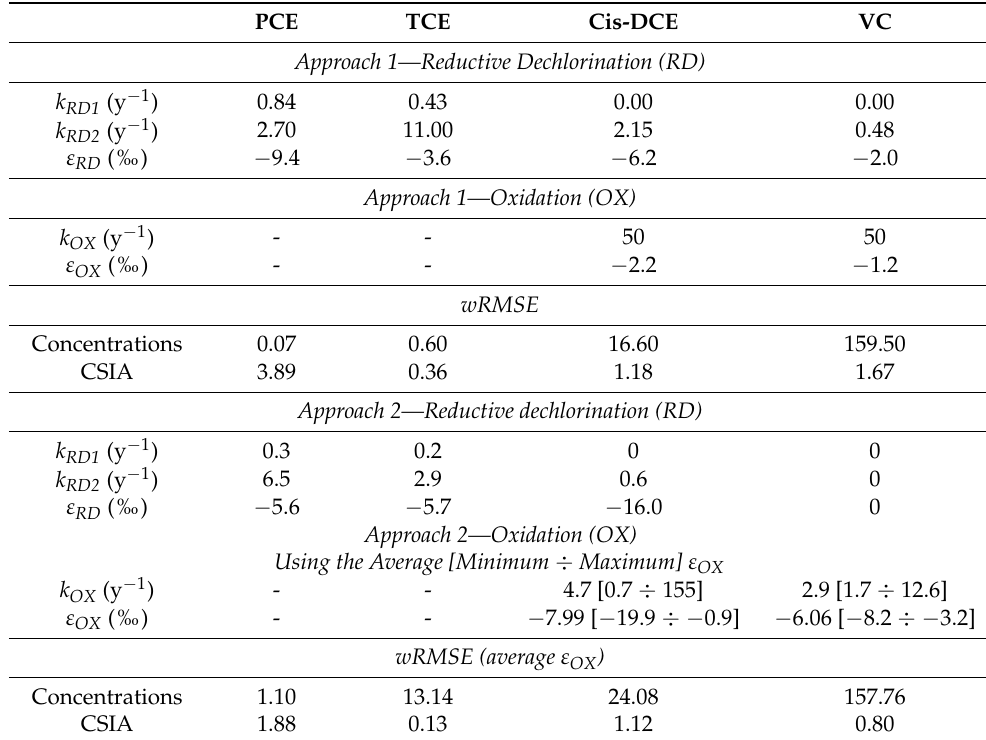
Table 6. Calibrated k and ε values for the tested scenarios with May 2021